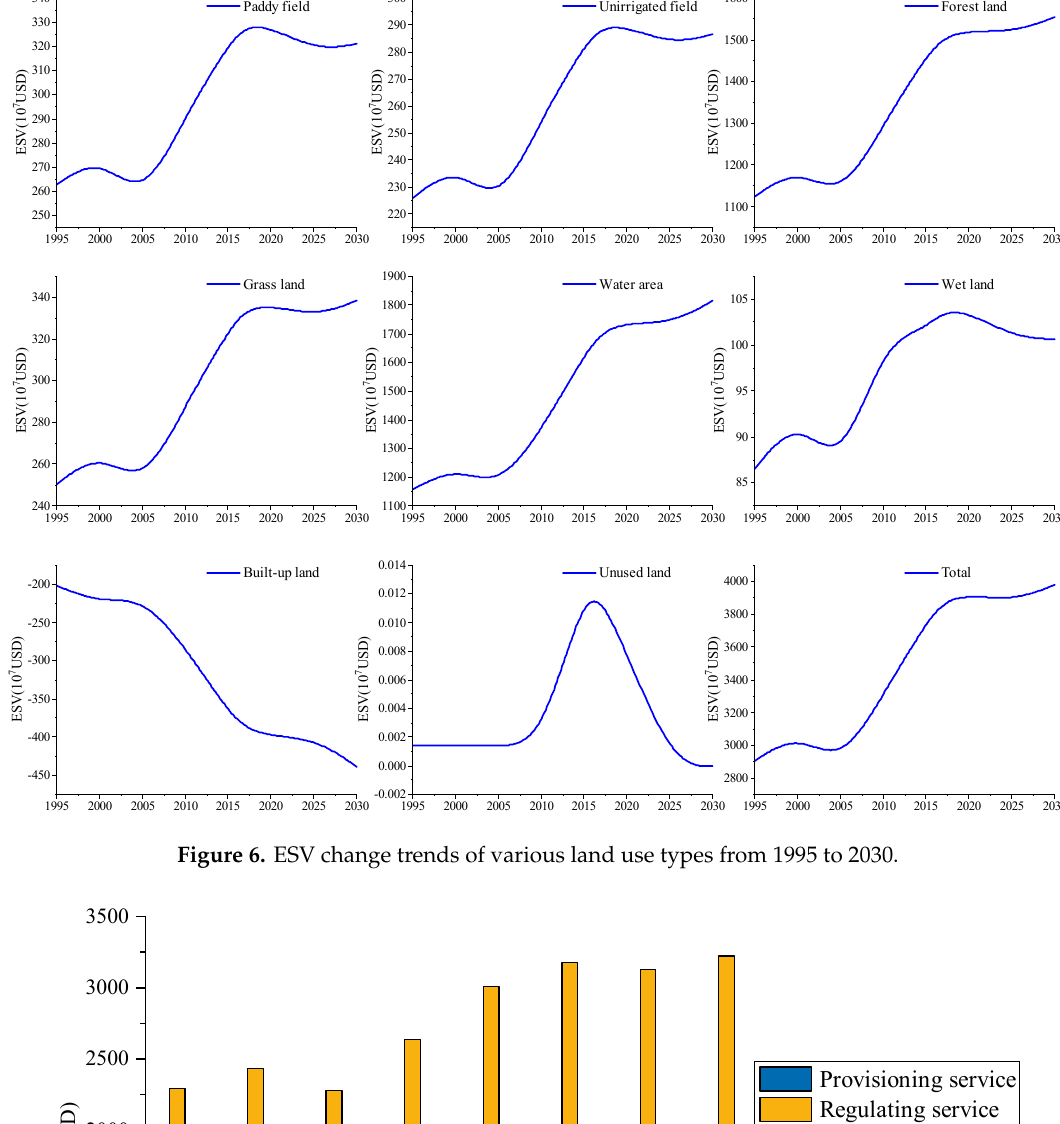
Figure 6. ESV change trends of various land use types from 1995 to 2030.